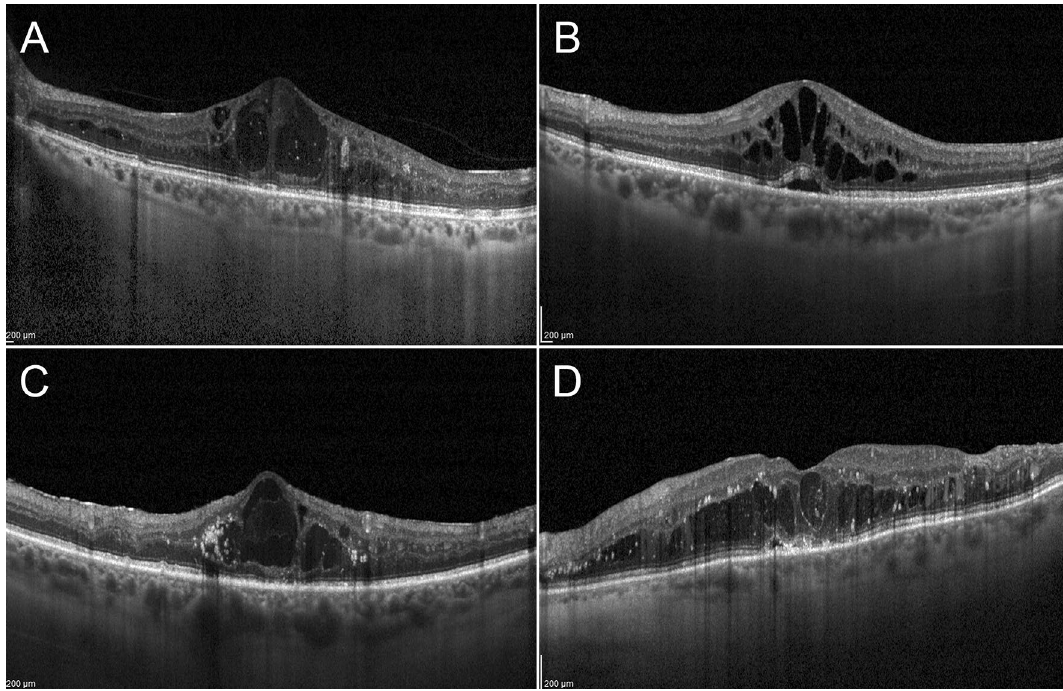
Figure 1. Diabetic macular edema categorization. Foveal eversion is classified as follows: Pattern 1a ( A ), showing a central columnar organization of the mixed reflectivity material; Pattern 1b ( B ), characterized by multiple thin central lines; and Pattern 2, showing no signs of central mixed reflectivity vertical material ( C ). A case of DME with no eversion of the foveal profile is shown in ( D